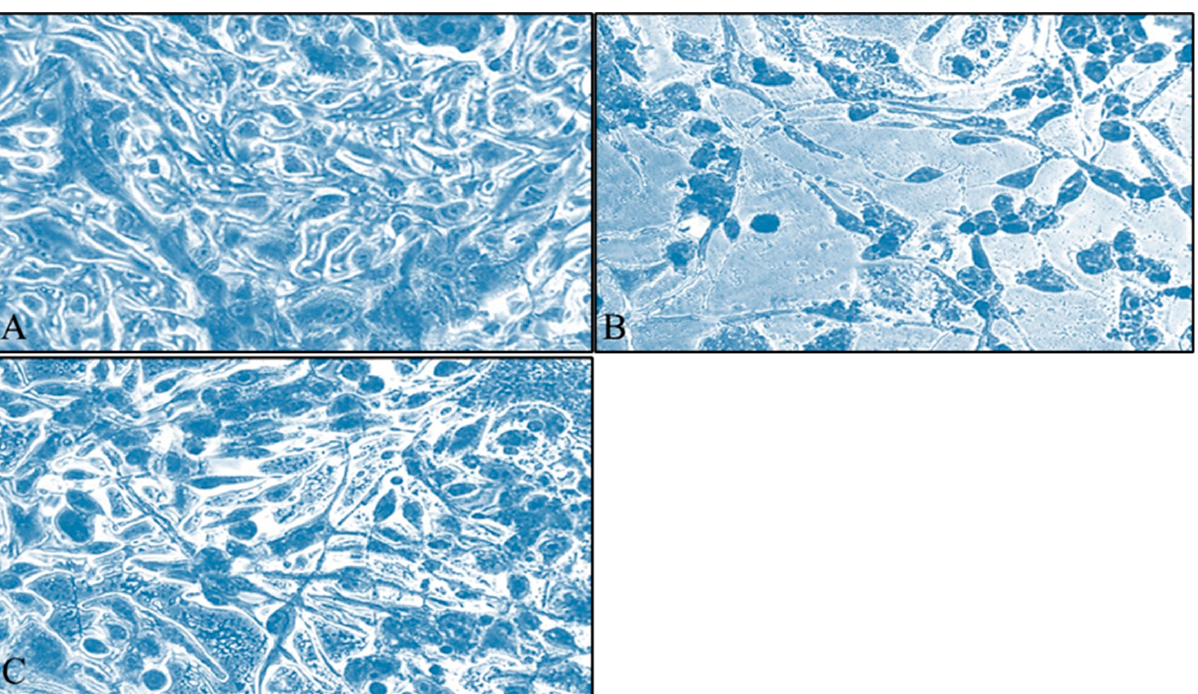
Figure 2. Microscopy inspection of the TE671 rhabdomyosarcoma cells, grown for 72 h in DMEM with no other treatment ( A ), cells treated with 0.78 mg/mL of the extract ( B ) and cells treated with 0.39 mg/mL of the extract ( C ). Images were captured at ×200 magnification.